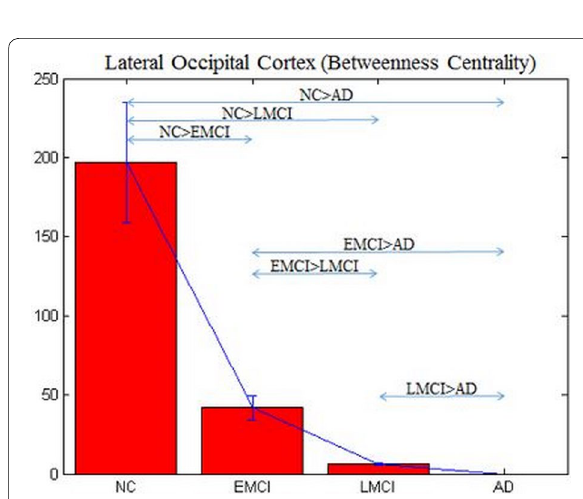
Fig. 4 Betweenness centrality (BC) of lateral occipital cortex (LOC) obtained from directed networks using Granger causality (GC), which was significantly different between the groups and deteriorated from NC to EMCI to LMCI to AD